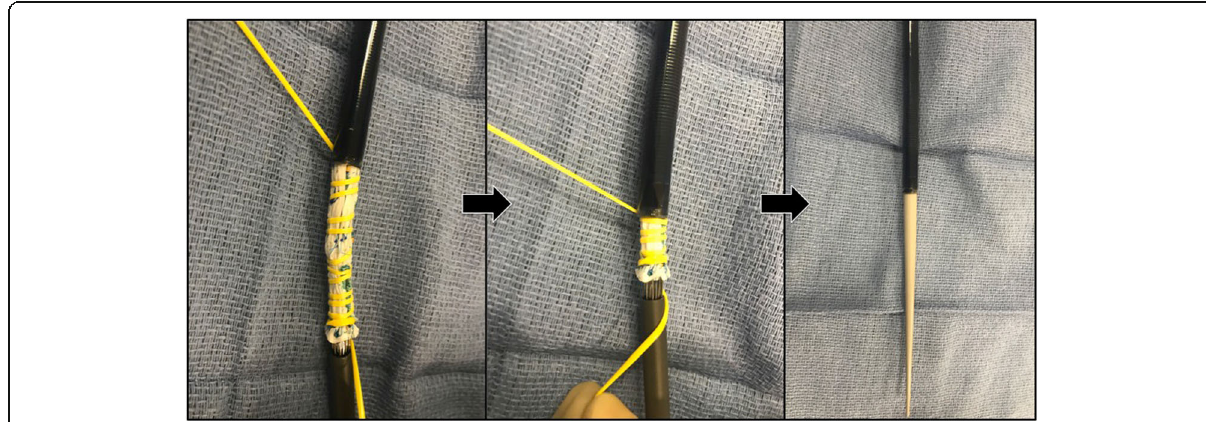
Table 1 Clinical characteristics of 121 patients undergoing fenestrated endovascular aortic repair (FEVAR) using the Zenith Fenestrated AAA Endovascular® with large fenestrations for superior mesenteric artery incorporation